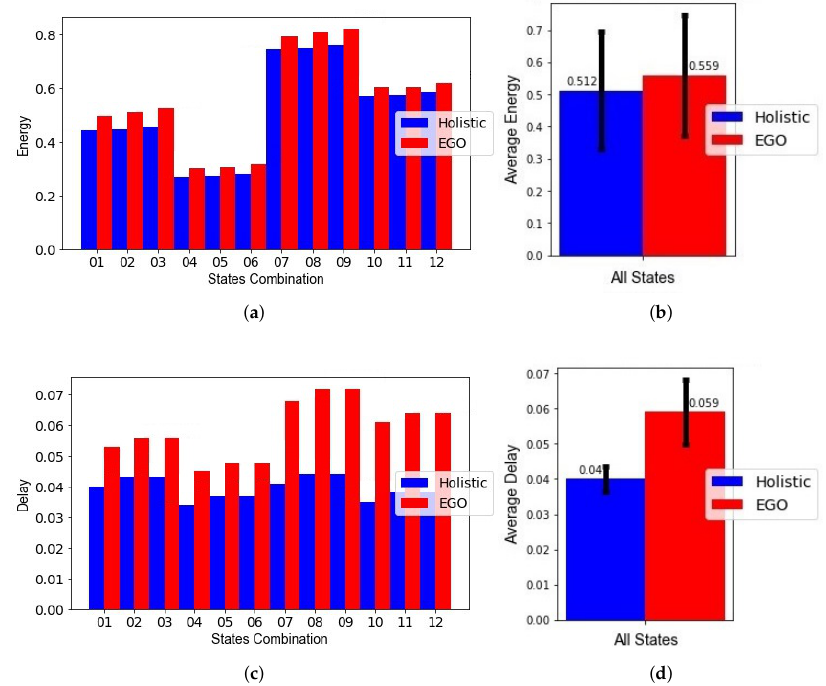
Figure 11. A comparison between EGO and the holistic approach both using the new behavioral model for ( a ) normalized energy and ( c ) normalized delay for each state’s combination scenario; ( b ) average normalized energy and ( d ) average normalized delay for all states’ combination scenarios.